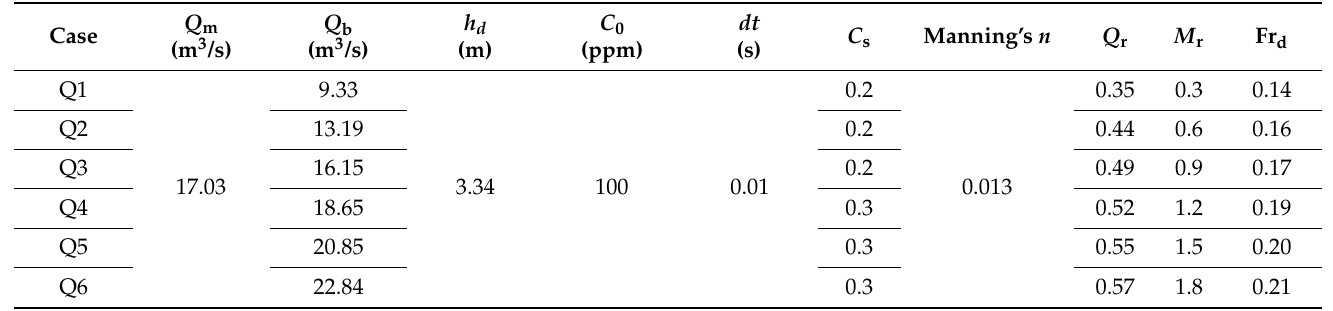
Figure 2. Computational mesh for simulations of solute mixing in the confluent channel. Table 1. Simulation conditions for flow and mass transport